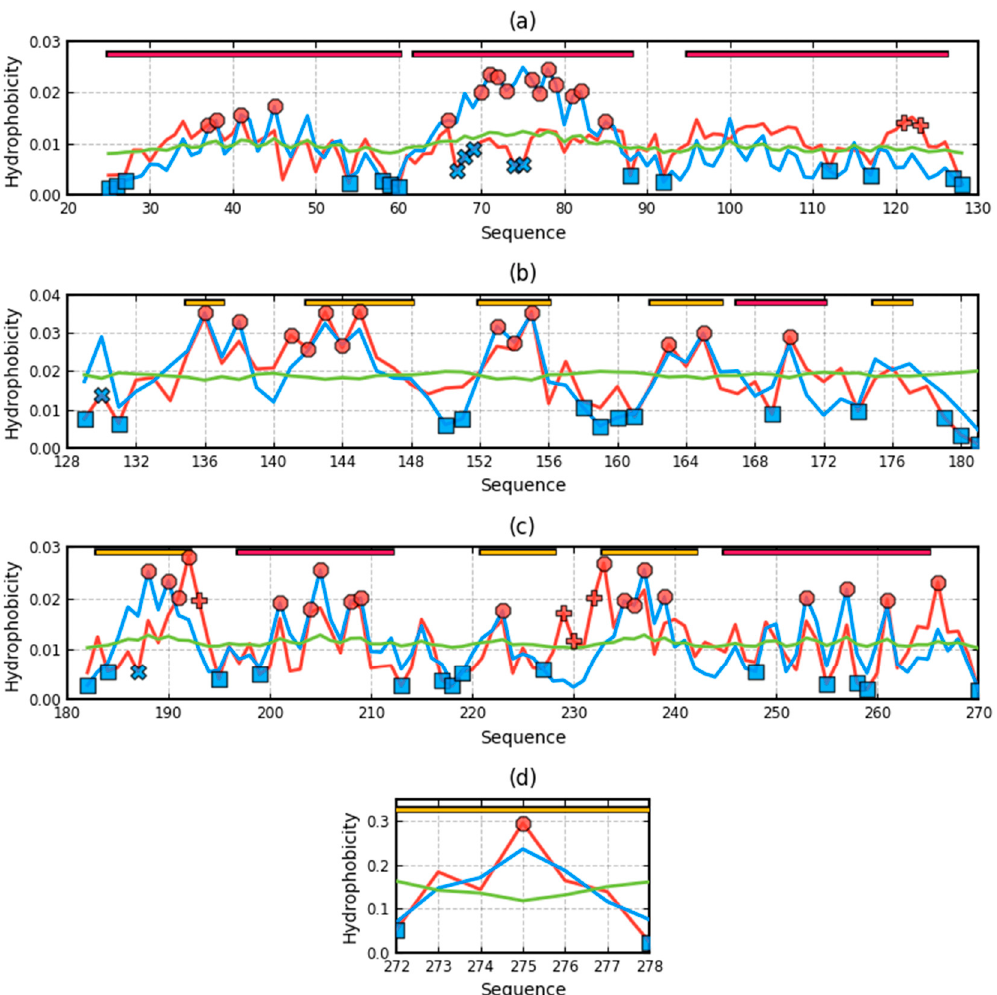
Figure 5. Profiles T, O, and M in domains of chain A treated as individual structural units (3D Gauss generated for each domain individually) ( a )—dom1, ( b )—dom2, ( c )—dom3, ( d )—beta-barrel. Distribution T—blue, O—red, M—green. Bars on top—presence of secondary forms: red—helix, yellow—beta-structure, red circles—residues potential hydrophobic core, blue X—residues of hydrophobicity deficiency—here residues in a channel, red “+”—residues of hydrophobicity excess on the surface potentially engaged in protein-protein complexation. The blue squares—residues on the surface representing low hydrophobicity—the status accordant with FOD